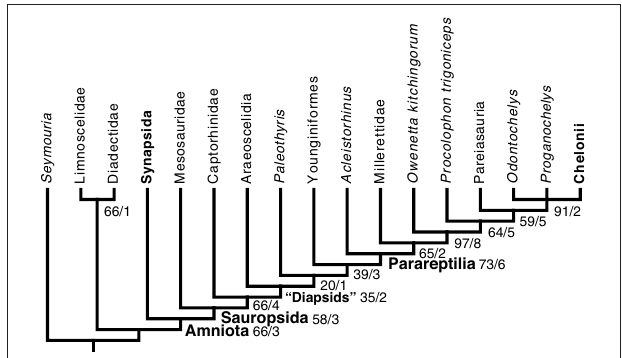
FIGURE 5 | Phylogenetic position of mesosaurs among early amniotes and selected related taxa. This cladogram results from a parsimony analysis of a matrix updated from that of Laurin and Reisz (1995) with our observations of mesosaur specimens (mostly from material collected in Uruguay, but also, to a lesser extent, material observed in Brazil, Germany, and France) and with recent literature. Characters that form a cline were ordered; the branch and bound algorithm of PAUP 4 was used. This is a strict consensus of two trees that require 383 steps (in Mesquite). They have a CI (Consistency Index) of 0.56527 and a RI (Retention Index) of 0.65741 (see text for details). Robustness of the results is shown through the bootstrap (based on